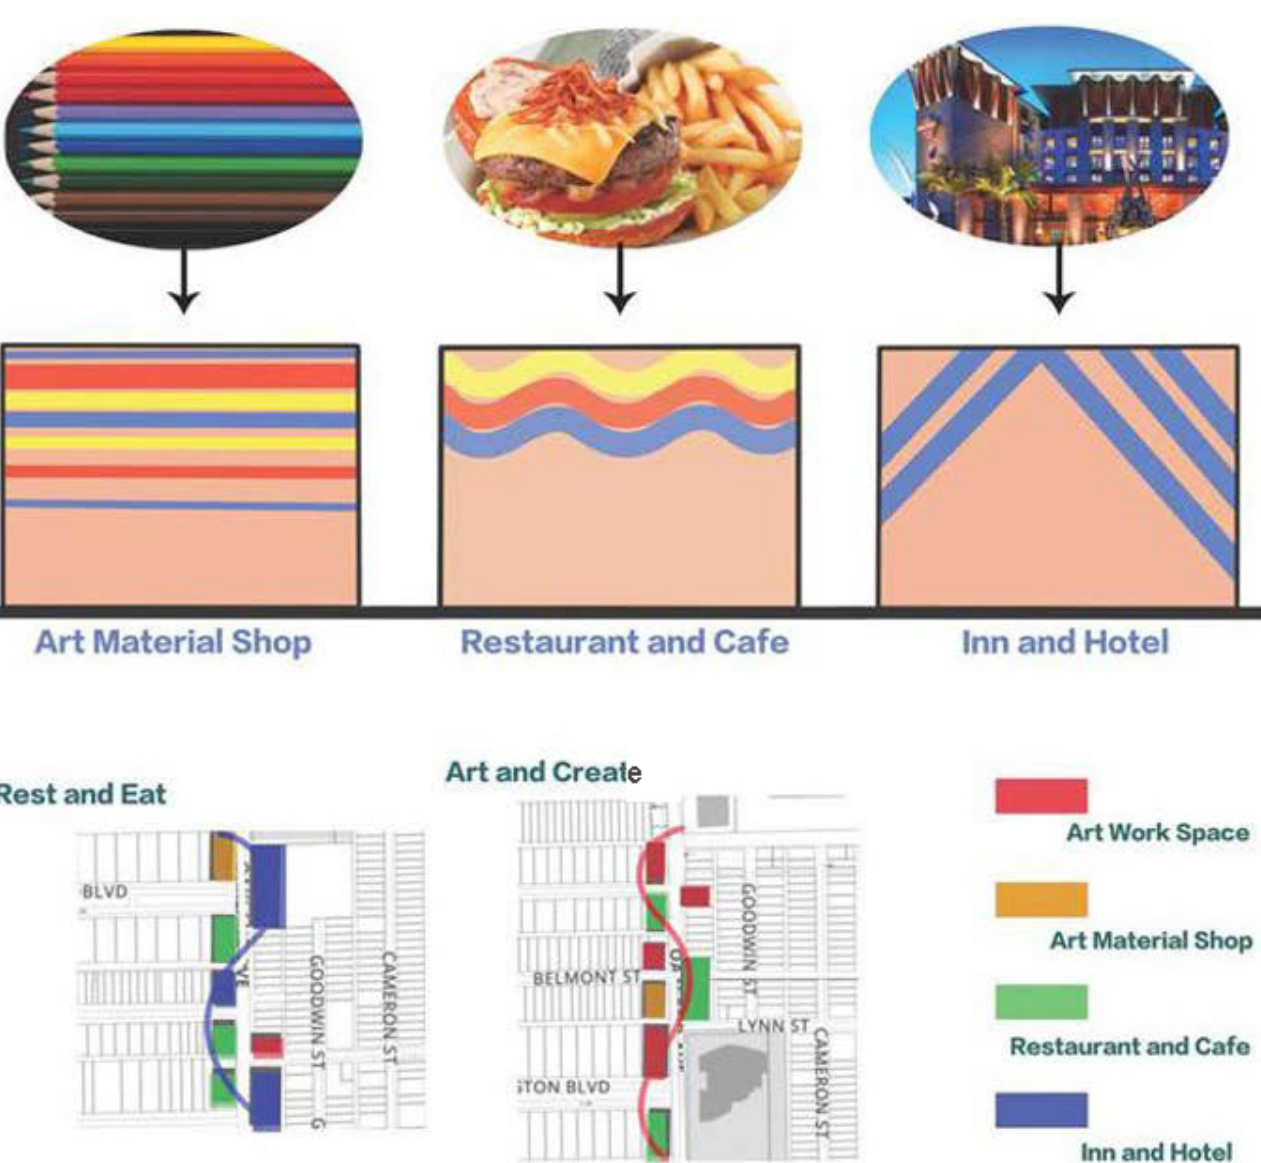
Figure 13. An example of a graphic language for mapping (co-developed by residents and design- ers).